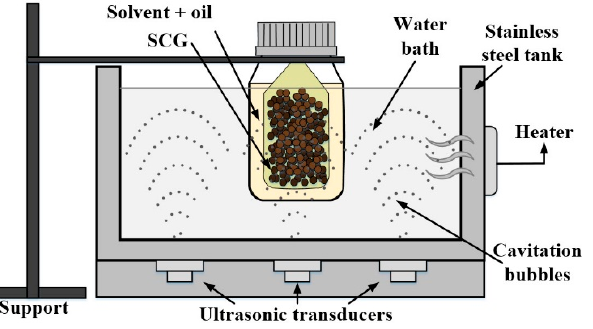
Figure 1. Experimental setup for the ultrasound-assisted extraction of SCG oil (own authorship).